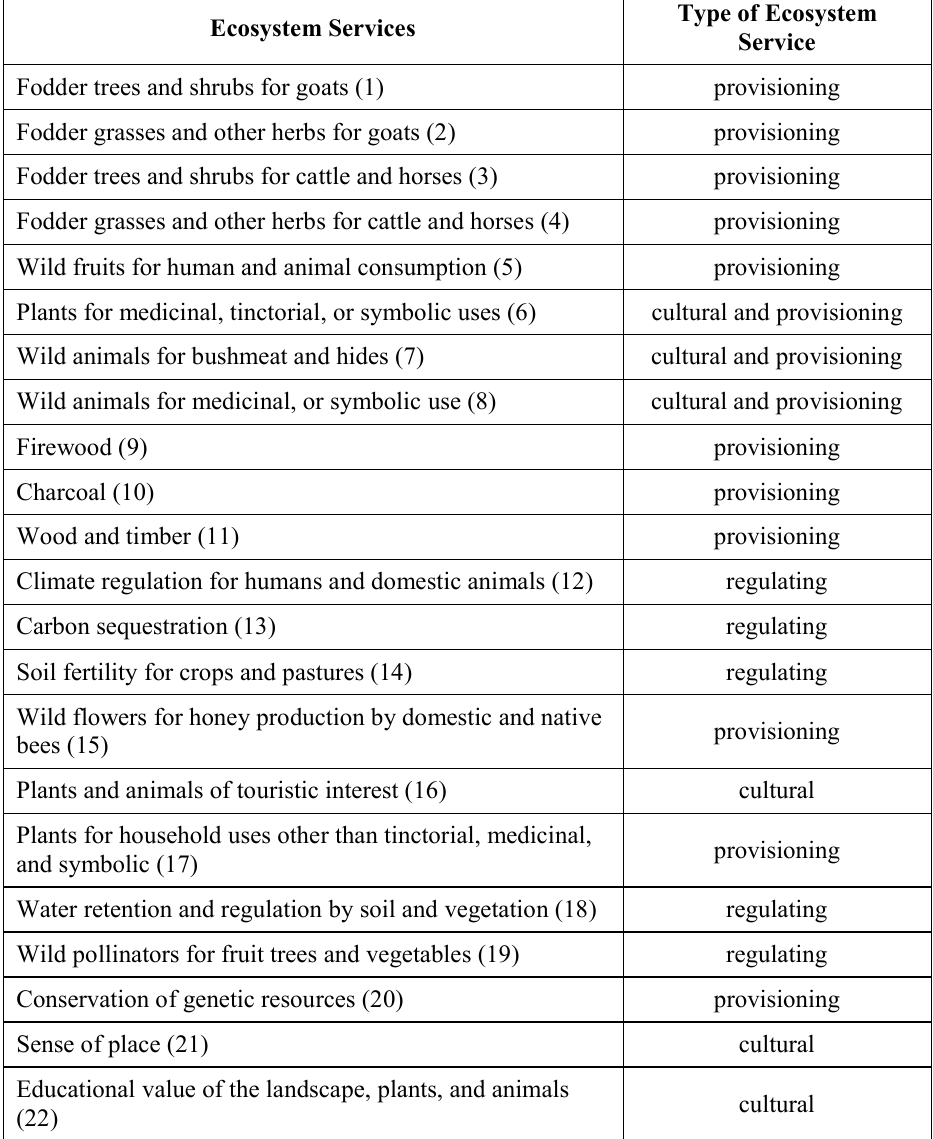
Table 1: Ecosystem services identified by stakeholders according to the Millennium Ecosystem Assessment categories (as defined in Carpenter et al. 2009). The numbers between brackets coincide with the order number in which they are listed in Figure